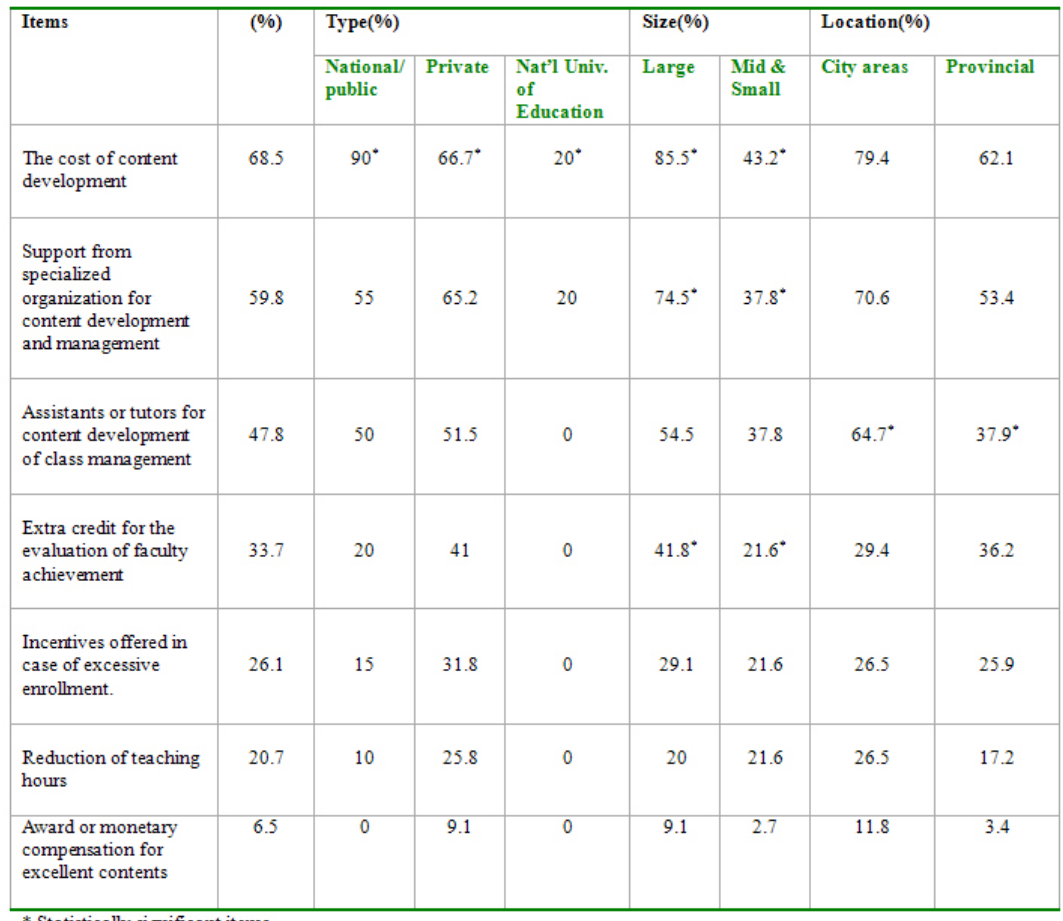
Table 3. State of Faculty Support for